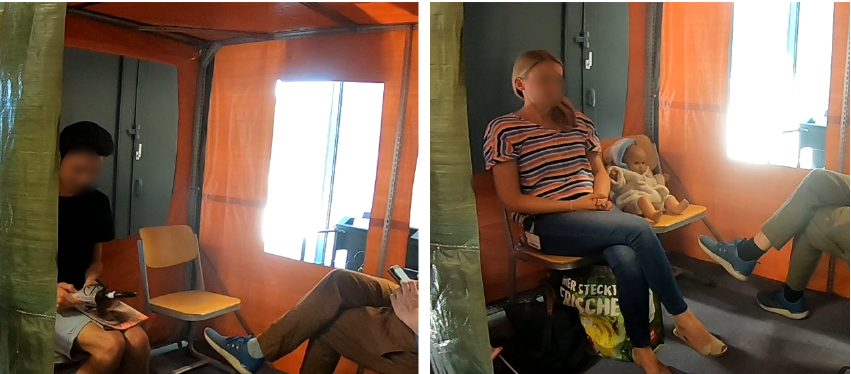
Figure 1. In the enactment part, participants were equipped with self-selected props and simulated a trip in an SAV shared with a stranger (enacted by one of our experimenters).